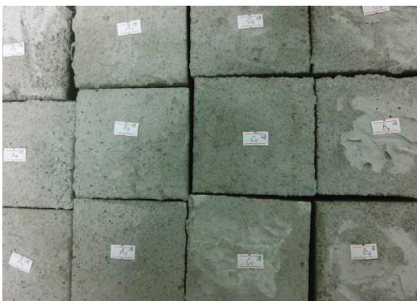
Figure 3: Test blocks in